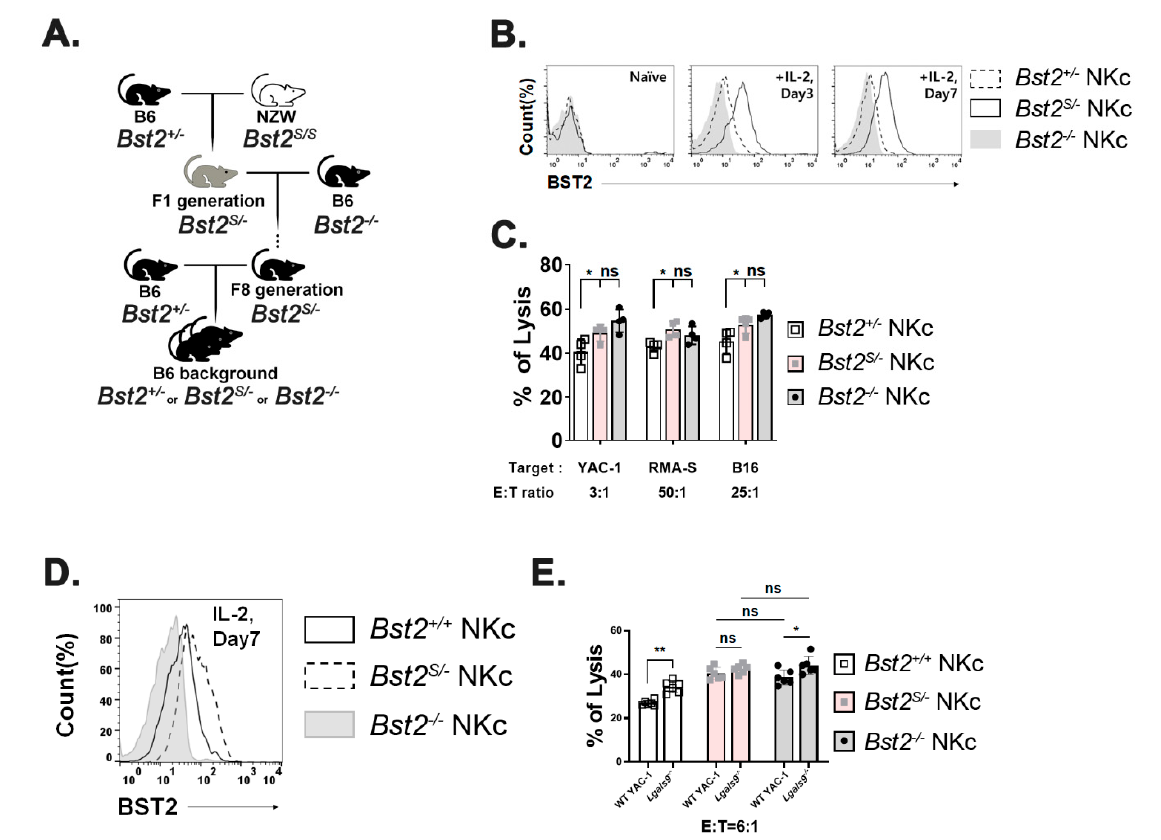
Figure 5. NK cells with short isoform of BST2 show enhanced cytotoxicity as well as BST2 deficient NK cells. ( A ) Backcross from NZW ( Bst2 S/S ) background to B6 background. ( B ) BST2 expression of LAK cells generated from splenocytes of B6-background Bst2 +/- , Bst2 S/- , and Bst2 -/- mice. ( C ) Calcein-AM stained target cells (YAC-1, RMA-S, and B16) were co-cultured with Bst2 +/- , Bst2 S/- , and Bst2 -/- LAK cells for 4 hrs at 37 ◦ C in a humidified incubator. Released calcein was measured to analyze cytotoxicity of effector cells as described in Figure 1. Data are representative of two independent experiments. Graphs showed mean ± S.D. ( n = 4 per group). ( D ) Naïve splenocytes of B6-origin Bst2 +/+ , Bst2 S/- , and Bst2 -/- mice were stimulated by IL-2 for seven days to generate LAK cells. Expression level of BST2 was measured through flow cytometry staining. ( E ) Calcein-AM stained target cells (YAC-1 and Lgals9 -/- YAC-1) were co-cultured with Bst2 +/+ , Bst2 S/- , and Bst2 -/- LAK cells for 4 hrs at 37 ◦ C in a humidified incubator. Released calcein was measured to analyze cytotoxicity of effector cells as described in Figure 1. Graphs showed a mean ± S.D. ( n = 6 per group). (*, p < 0.05; **, p < 0.01; n.s., not